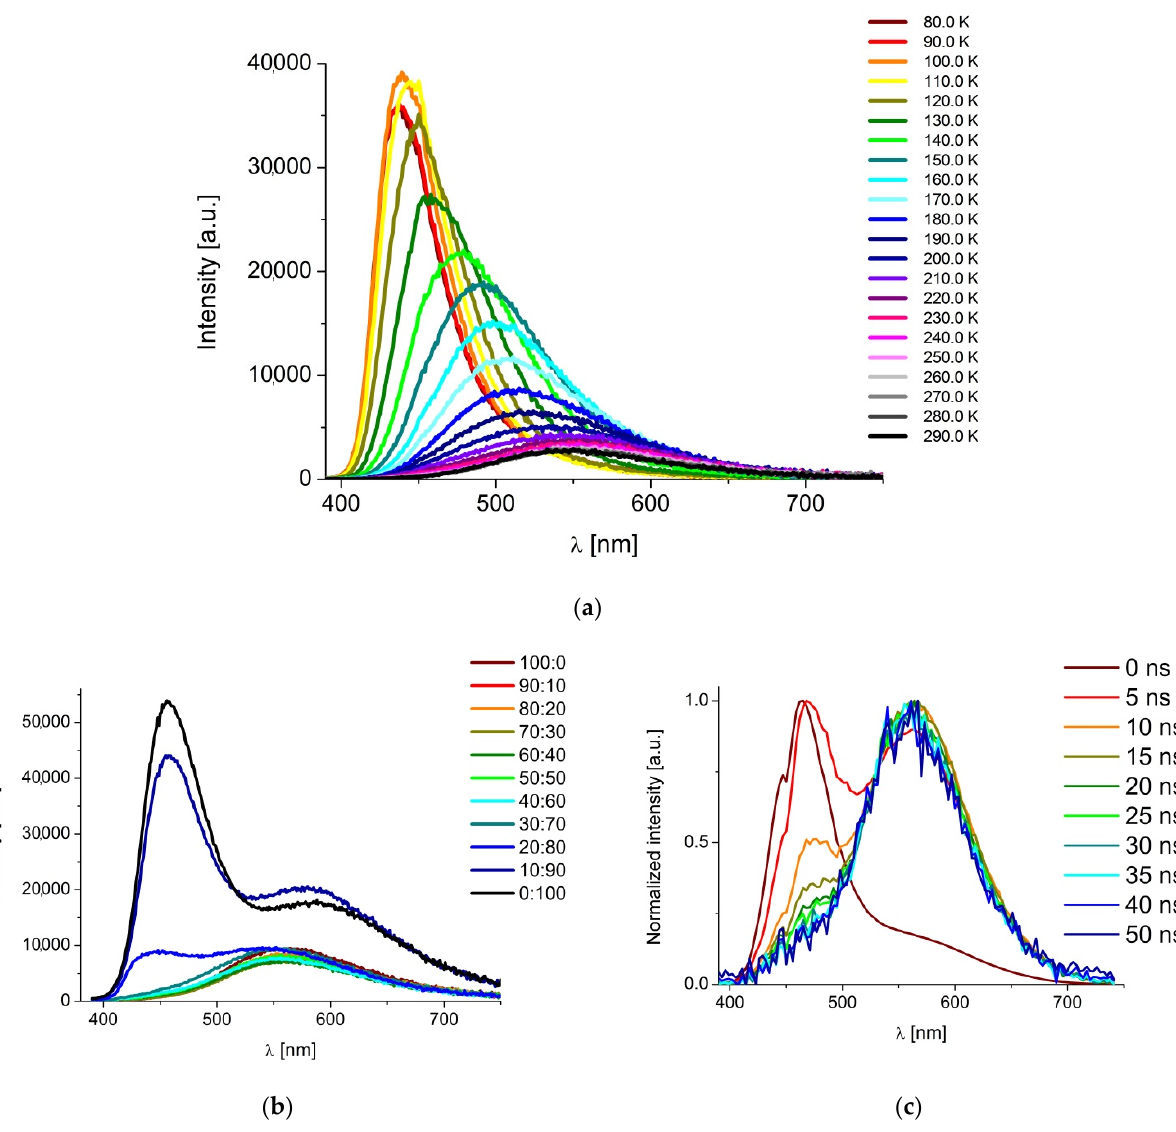
Figure 5. ( a ) PL spectra of tBuTPAterpy in a methanol: ethanol mixture (1:4) at different temperatures (c = 10 µ M; λ PE = 375 nm); ( b ) Steady-state emission spectra of tBuTPAterpy in methanol: glycerol mixtures with different fraction of the two solvents (c = 10 µ M, λ PE = 370 nm); ( c ) Normalized tBuTPAterpy TRES traces at different time delays in glycerol (room temperature, c = 10 µ M, λ PE = 375 nm; emission slit: 2 nm; detector signal: 6000 cps, wavelength step: 3 nm, stop condition: 300